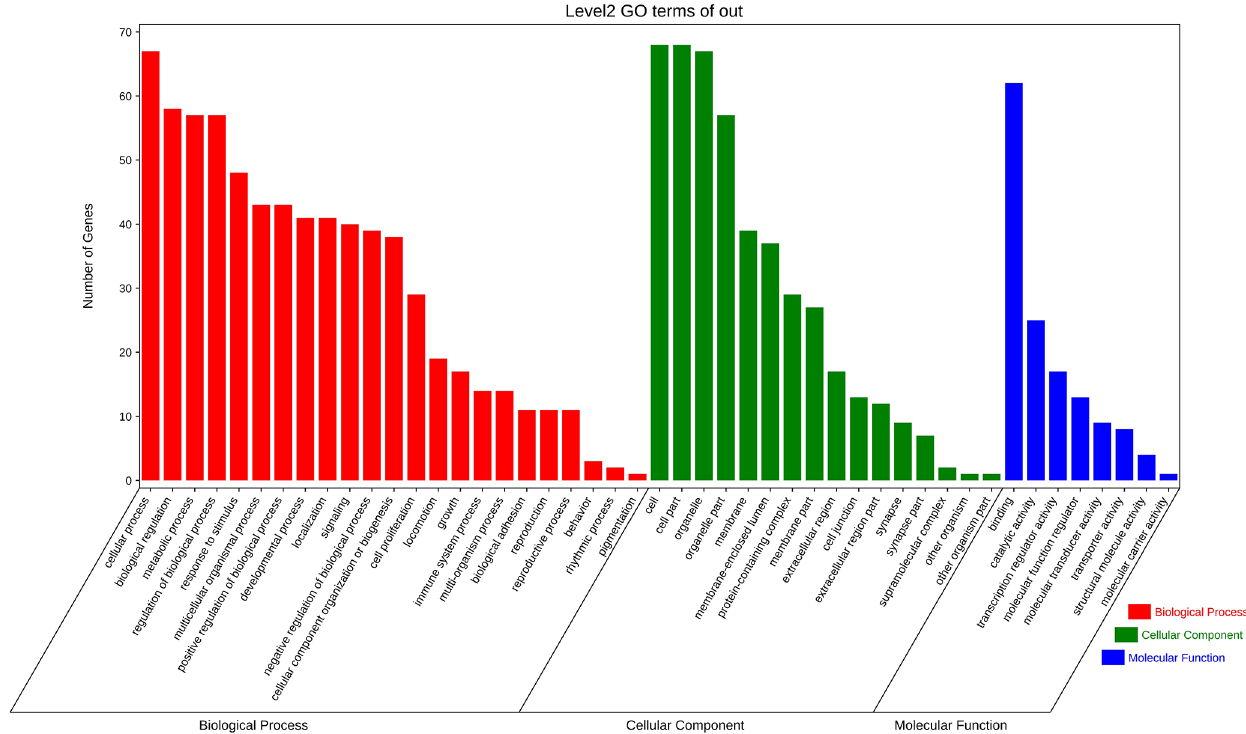
Figure 6. Seventy-three target genes were analyzed using taxonomic annotation and enrichment analysis in terms of molecular function, biological process, and cell composition.